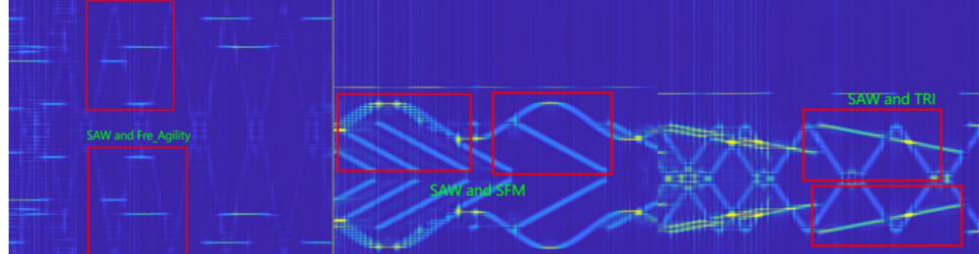
Figure 9. Mixed feature markers.